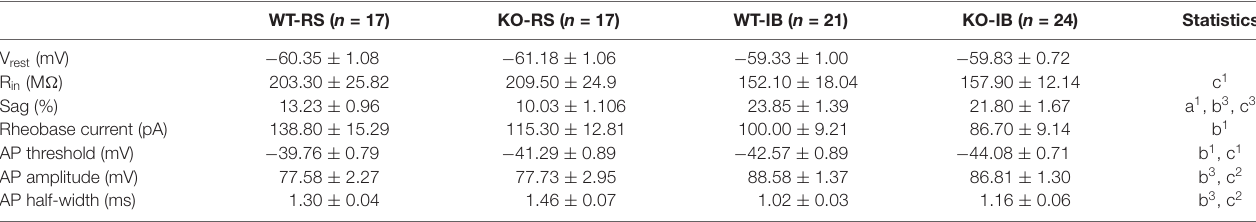
TABLE 2 | Electrophysiological properties of layer 5 pyramidal